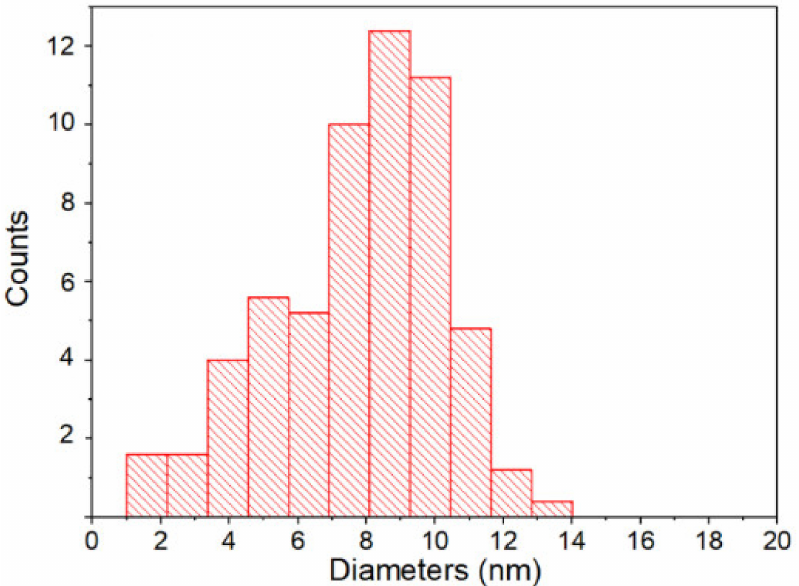
Figure 2. The histogram of Ag/Au@LCC nanoparticles size